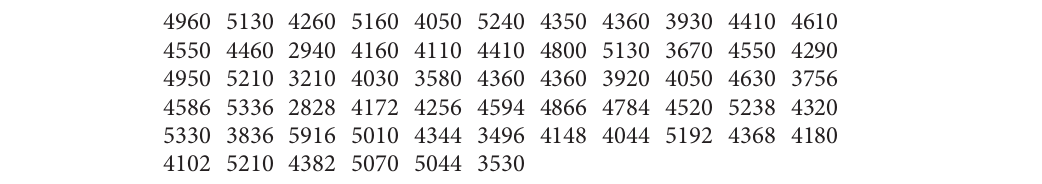
Algorithm 1: Shapiro-Wilk test for normality of the weights of 61 one-month old